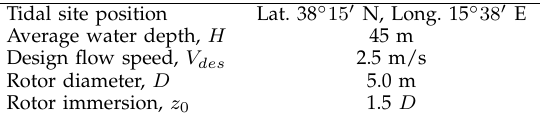
TABLE IV T IDAL SITE CONDITIONS